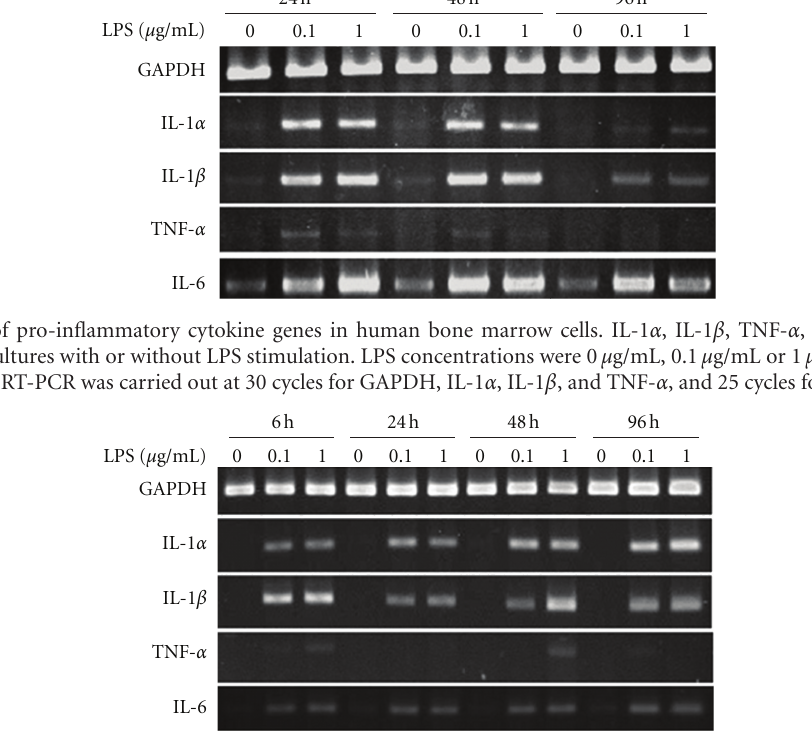
Figure 4: Expression of pro-inflammatory cytokine genes in mouse macrophages (RAW 264.7). Gene expression of IL-1 α , IL-1 β , TNF- α , IL-6, and GAPDH in mMO cultures in the absence (0 μ g/mL) and presence (1 μ g/mL) of LPS. RNA was isolated at 12, 24, 36, 48, and 60 hours. RT-PCR was carried out at 30 cycles for all genes in this experiment. 24 h